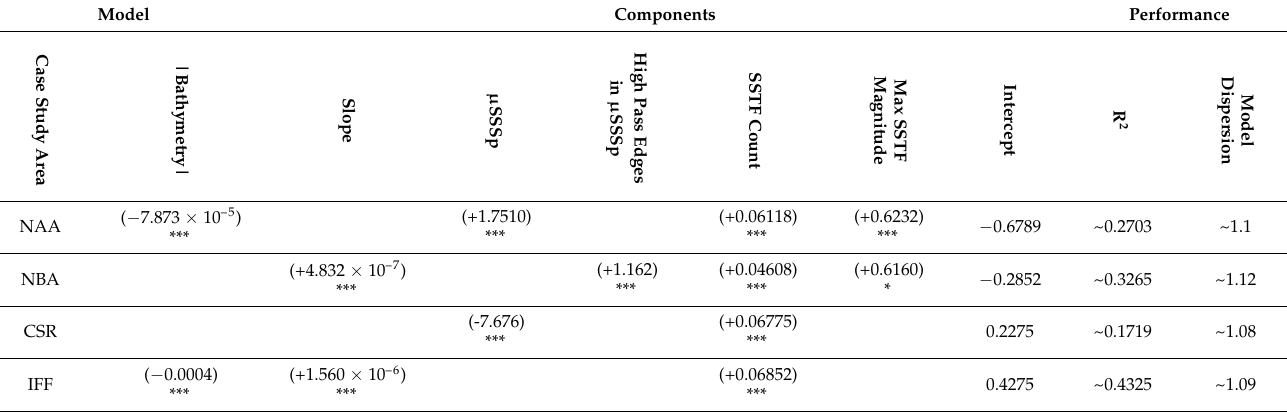
Table 2. Details of the Generalised Linear Models, developed to describe each of the four case study areas. Only significant effects are included in the table. Coefficients for the different variables are shown in brackets, with the level of significance indicated using asterisks. Note that SSSp = Sea Surface Current Speed, and SSTF = Sea Surface Temperature Front. Model Components